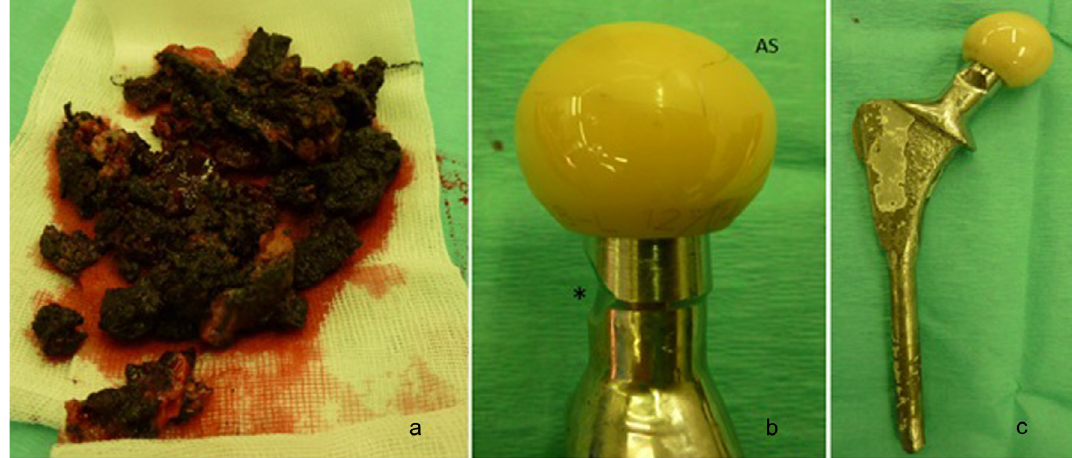
Figure 2. (a) Black metal debris, (b) excessive wear of antero-superior (AS) femoral head and at posterior stem neck (*), (c) femoral stem with attached head.